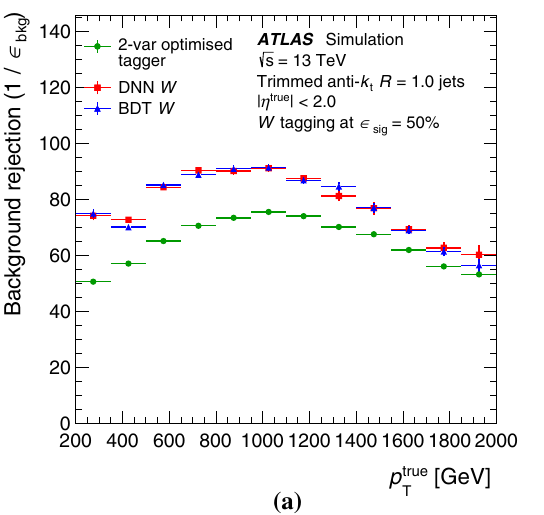
W -boson jet tagging and m comb and τ 32 for top-quark jet tagging. The performance is evaluated with the p true distribution of the signal jets T weighted to match that of the multijet background samples. Statistical uncertainties of the background rejection are